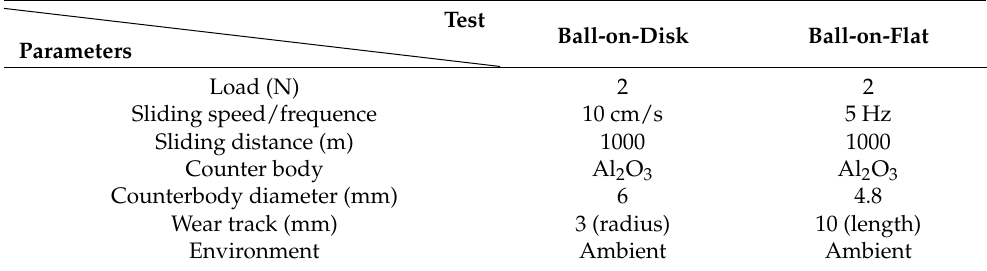
Table 3. Parameters of sliding wear